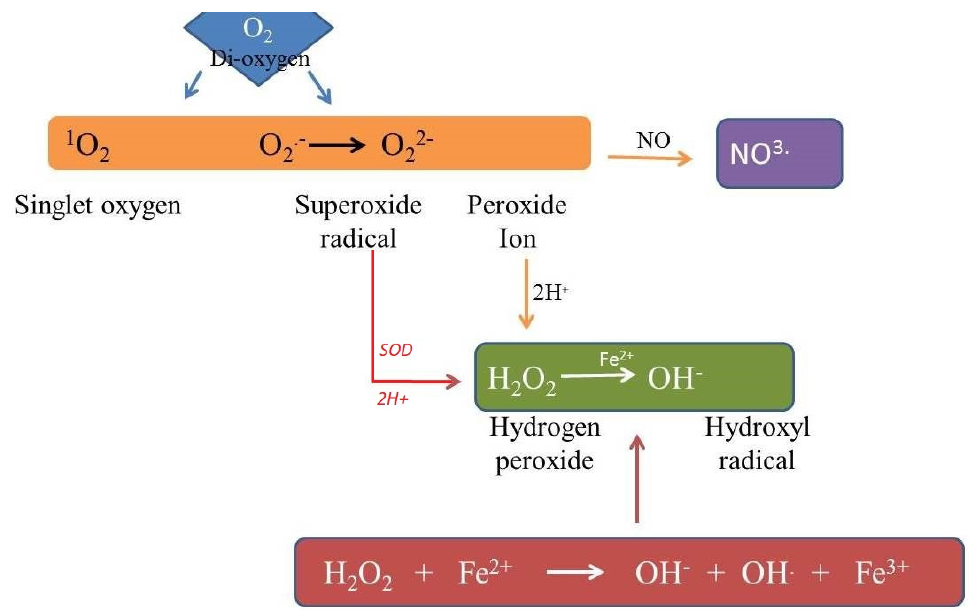
Figure 3. Atmospheric oxygen is shown to undergo excitation or reduction to form different ROS and reactive nitrogen species; super oxide dismutase is shown to form hydrogen peroxide (H 2 O 2 ), which in turn reacts with Fe 2+ to form hydroxyl radicals (OH − ) via the Fenton reaction. Thus, ROS signaling is a highly regulated process and is mediated by the accumula- tion of ROS levels at specific cellular compartments. This may occur by plasma-mem- brane-bound NADPH-oxidase in plants and RBOH termed as NOX in animals. These are those enzymes that produce ROS in the apoplast [25,93–95]. This class of enzymes is also found in other cell organelles, such as endoplasmic reticulum (ER), vacuoles, nuclei, mi- rylation/dephosphorylation reactions (Figure 4) [25,94]. In addition, ROS levels